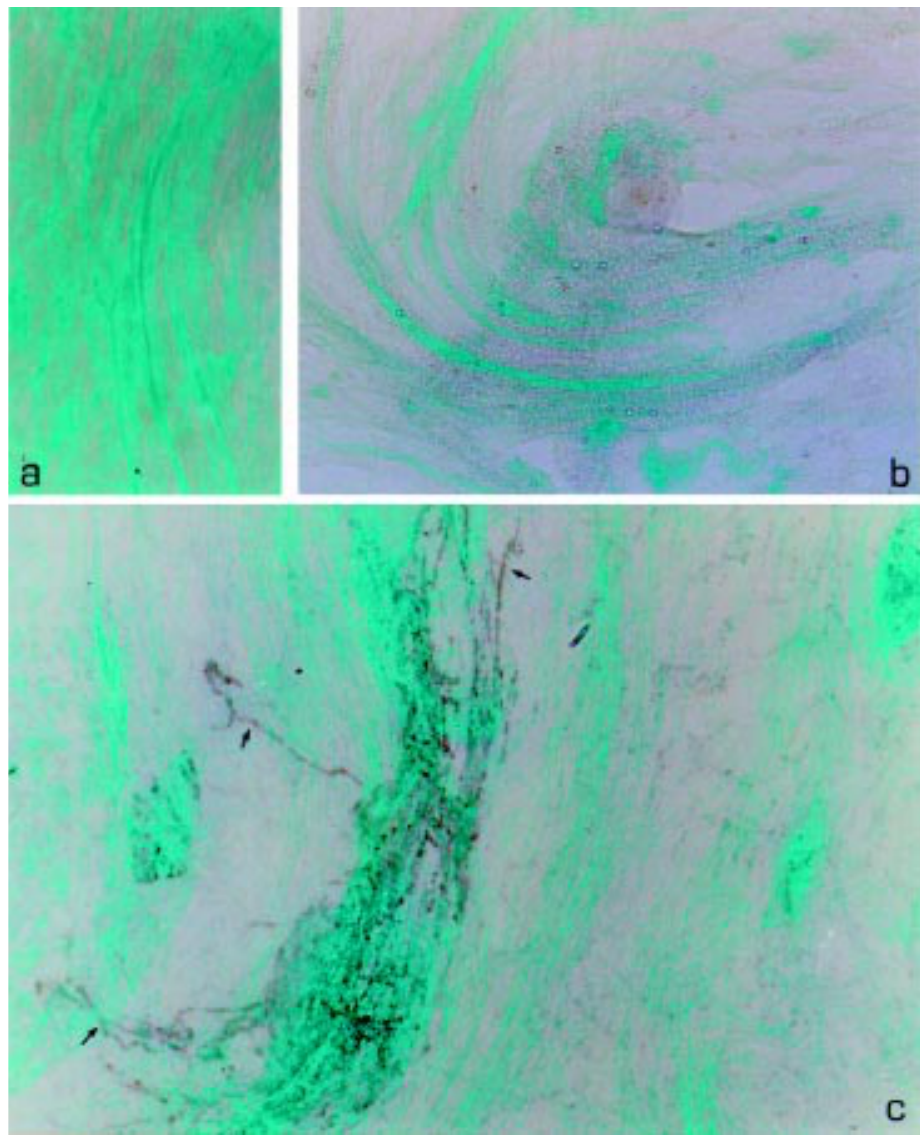
Figure 2 - Sperm cells of T. infestans 7 ( b ) and 30 ( c ) days after exposure of the insect to short-duration heat shock. a , Control. The arrows in c indicate DNA fragmentation revealed by the TUNEL assay.